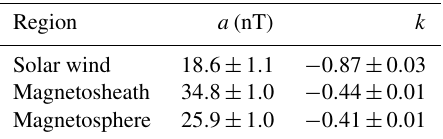
Table 3. Fitting parameters of Eq. (5) with 95% confidence inter- vals, exhibited from linear least squares fits of the offset accuracies above 0 . 5nT in Fig. 4. a is the 2 σ confidence of the best-estimate O zf determined from only one offset O z and k is the spectral index of the power